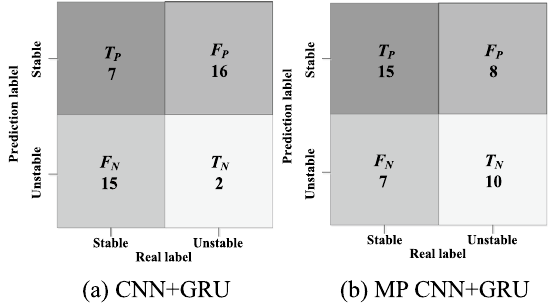
Fig. 7 TSA analysis results on the IEEE 39-bus system